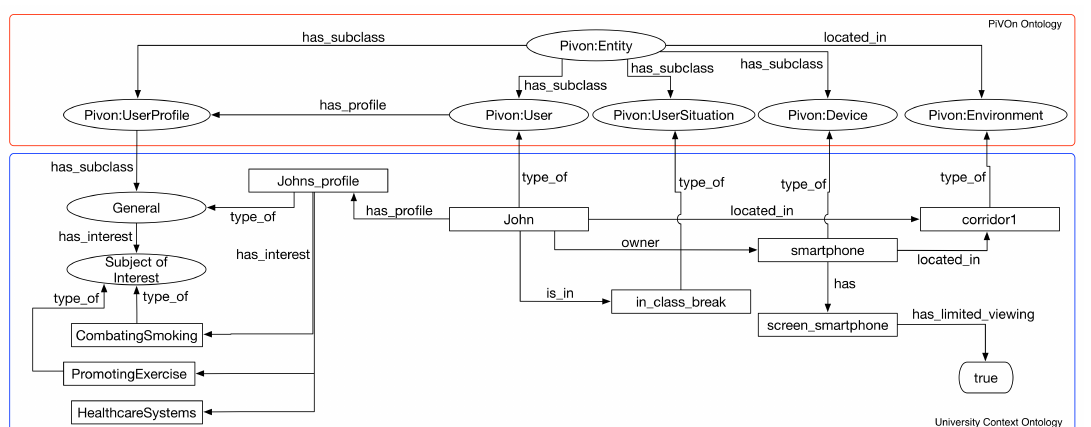
Figure 14. Context of interest related to Storyboard